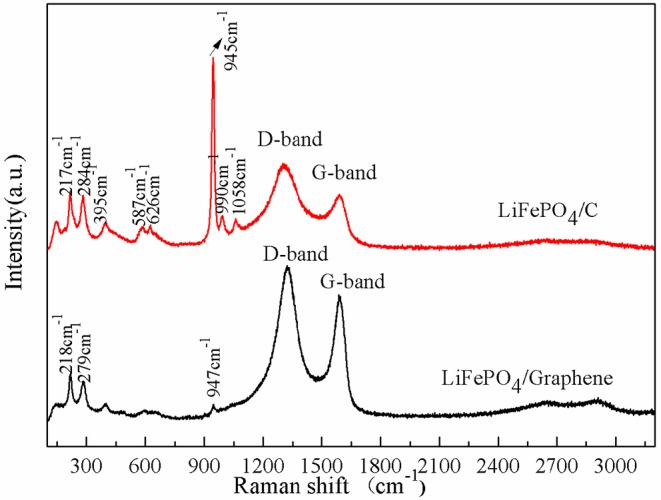
Raman spectra of LiFePO4/graphene and LiFePO4/C composites.